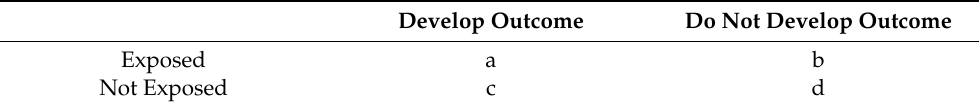
Table 1. The four-cell table for calculating RR of